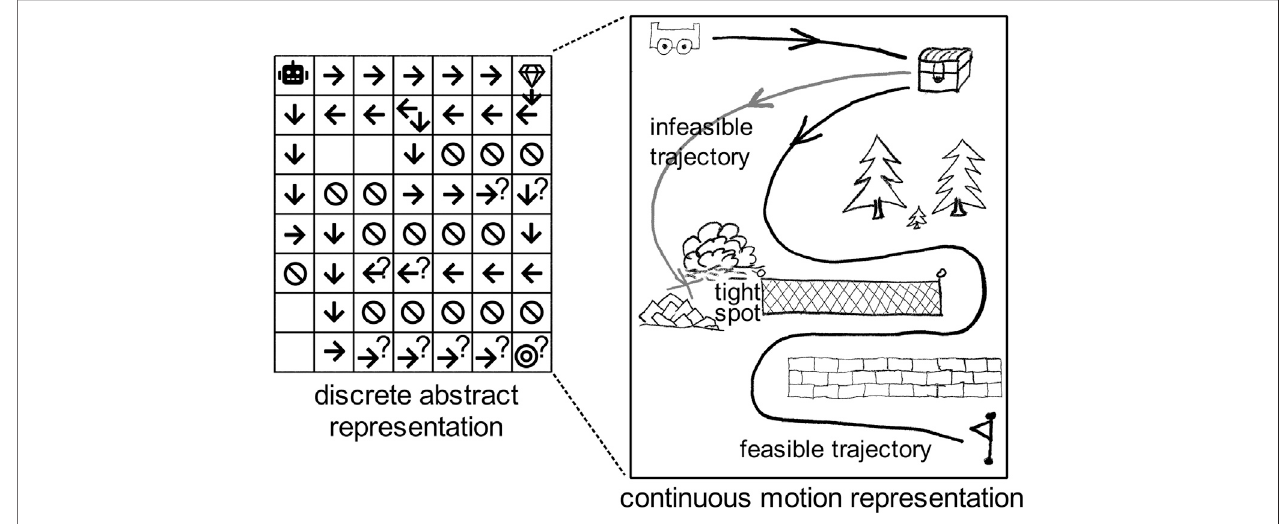
FIGURE1| ExampleofcombiningTAMPusing anabstract and amotionrepresentation withuncertainty(questionmarks)andtwoabstract solutionsofwhichone is infeasible due to a tight spot.